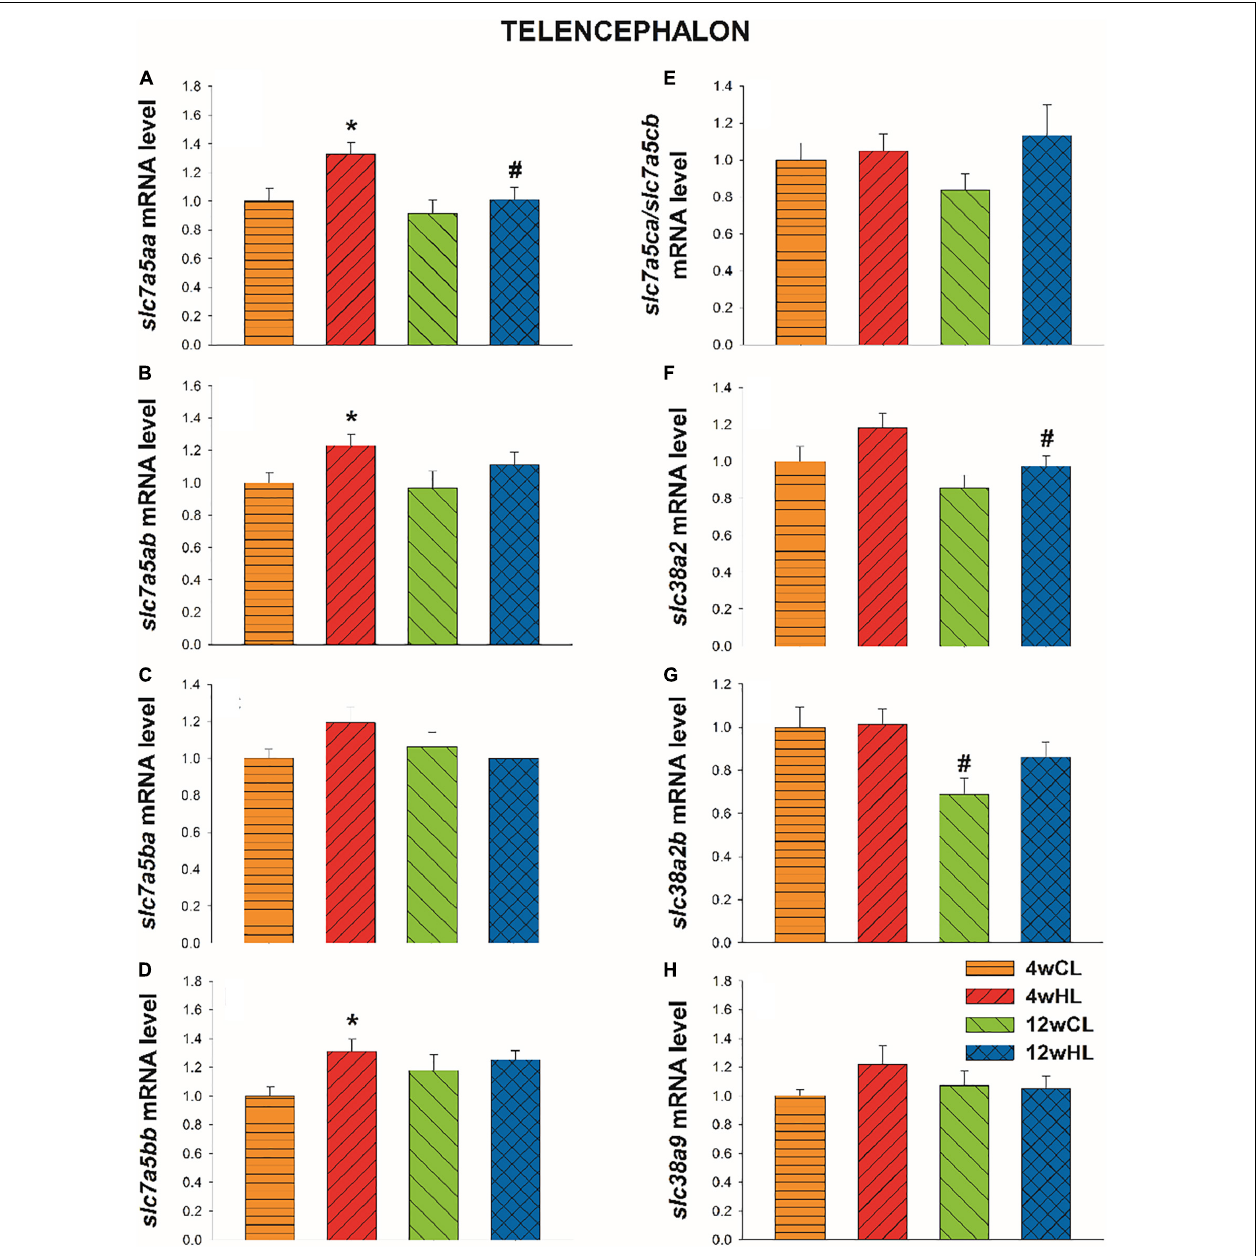
FIGURE 7 | Telencephalon mRNA level of slc7a5aa (A) , slc7a5ab (B) , slc7a5ba (C) , slc7a5bb (D) , slc7a5ca / slc7a5cb (E) , slc38a2a (F) , slc38a2b (G) , and slc38a9 (H) of Atlantic salmon after four (4w) or 12 weeks (12w) of feeding with control leucine diet (CL; 27.3 g/kg) or high leucine diet (HL; 35 g/kg). Each value is the mean ± SEM of n = 12 samples per tissue. Gene expression results are relative to fish fed CL for 4w and are normalised by actb ( β -actin). *, significantly different ( P < 0.05) from fish fed with LL within the same time. #, significantly different ( P < 0.05) from fish fed for 4 weeks with the same